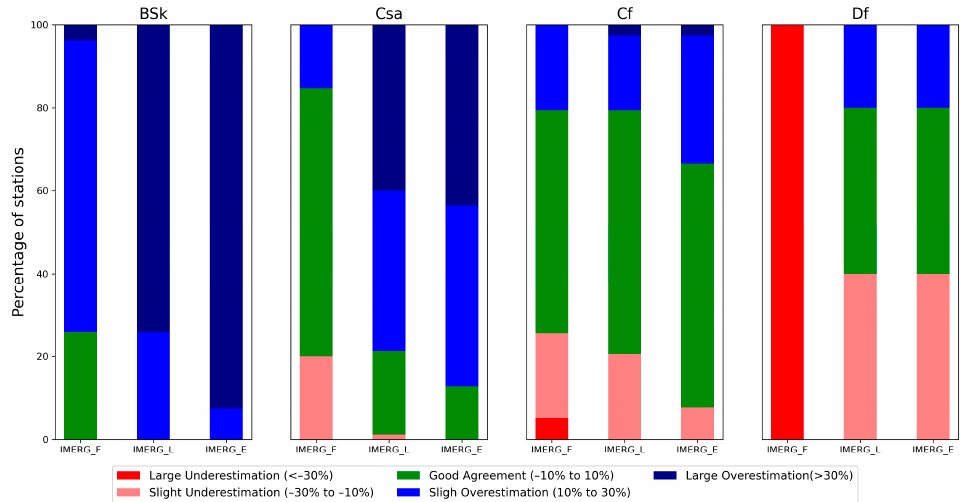
Figure 9. Stacked bars of the half-hourly relative error ( Rbias ) computed for each group of station for each climatic group. The colours represent the five categories of Rbias described in the legend.